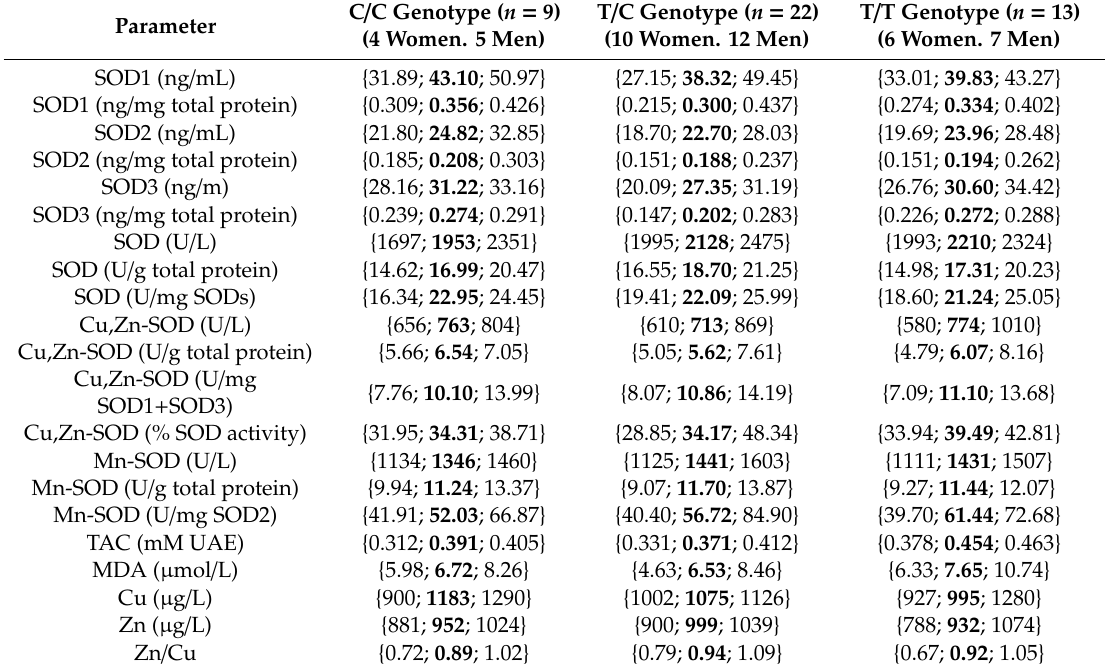
Table A4. Values of selected pro- and antioxidative parameters, and concentration of selected metals, in context of genotypic variability of rs927450 ( SOD2 ), in obese